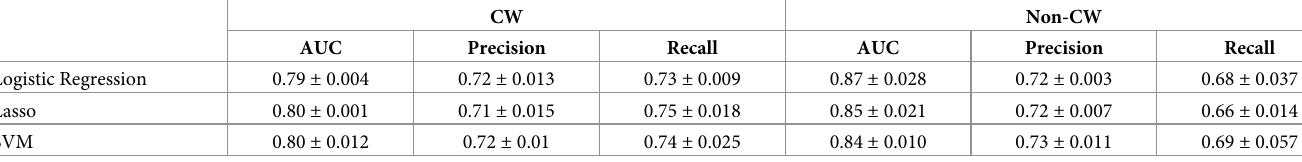
Table 3. Performance metrics for the three machine learning approaches.